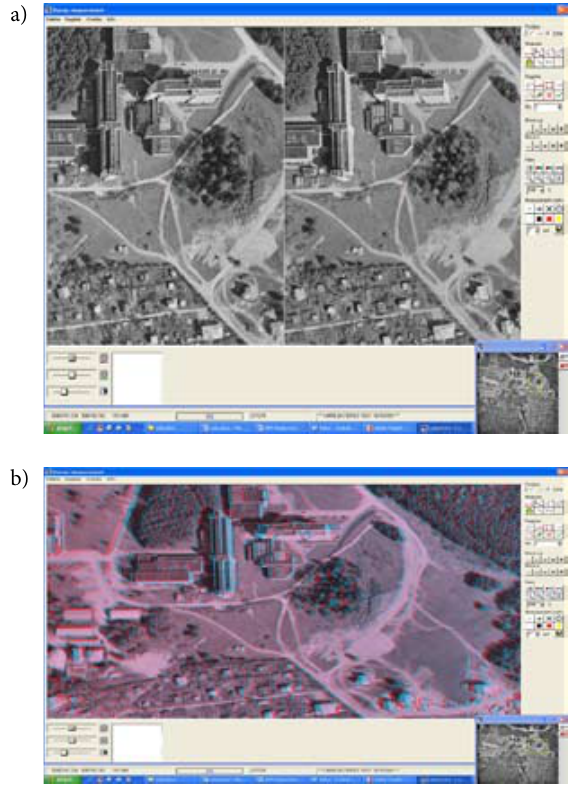
Fig 4. Created photogrammetric stereo model: a) for monocular measurements, b)